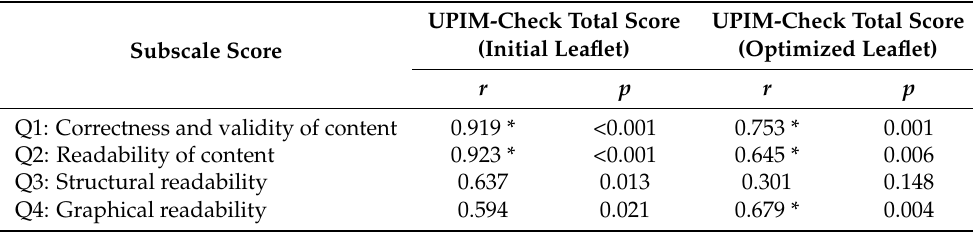
Table 3. Spearman’s correlations of the UPIM-Check total score with subscale scores according to the initial and optimized